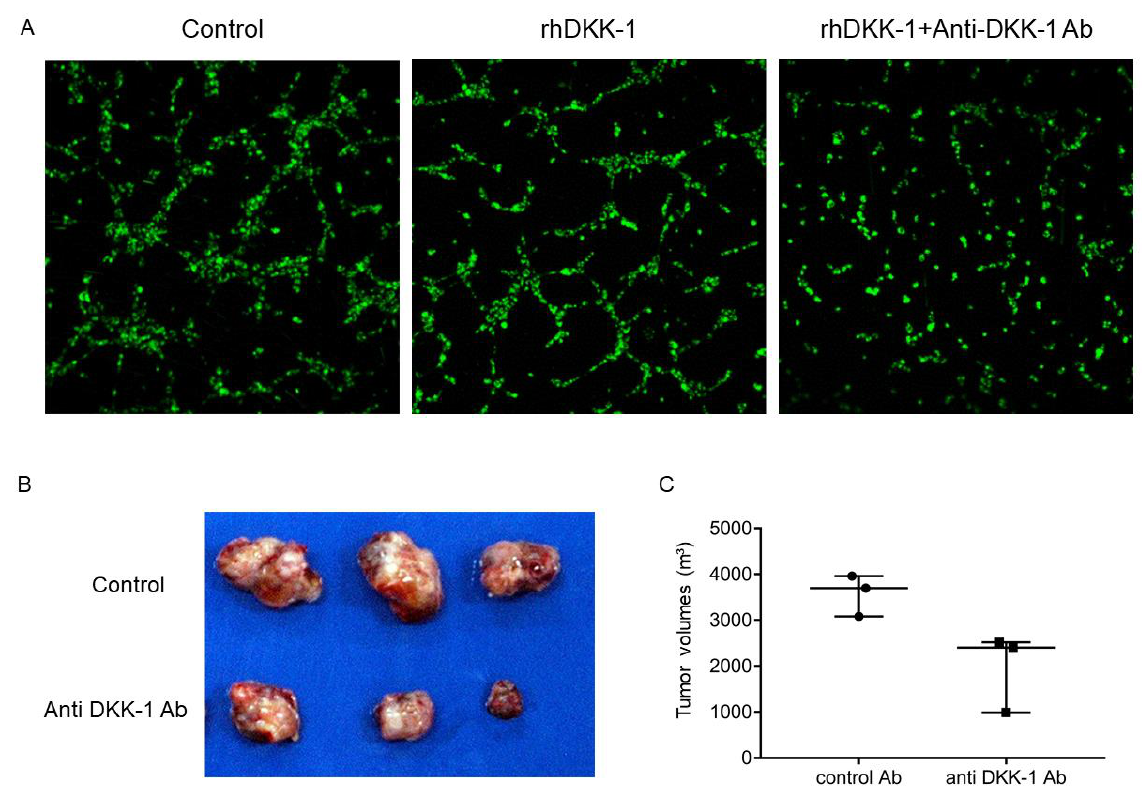
Figure 7. The effect of Dickkopf-1 (DKK-1) on angiogenesis and tumorigenesis. ( A ) Time-lapse image analysis of tube formation using human umbilical vein endothelial cells. DKK-1 treatment slightly accelerated tube formation compared with the control 2 h after treatment. This effect was abolished by the administration of anti-DKK-1 neutralizing antibodies. ( B , C ) Co-administration of anti-DKK-1 neutralizing antibody with Huh7 cells suppressed tumor growth in NOD/SCID mice compared with control IgG ( n =3 for each